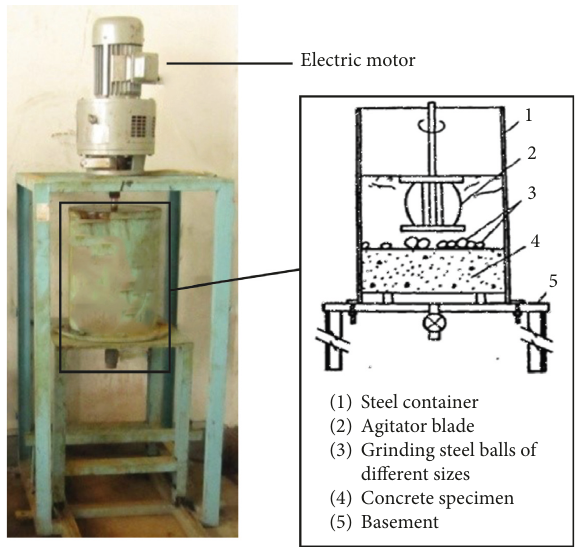
Figure 10: Underwater steel ball mill test apparatus.